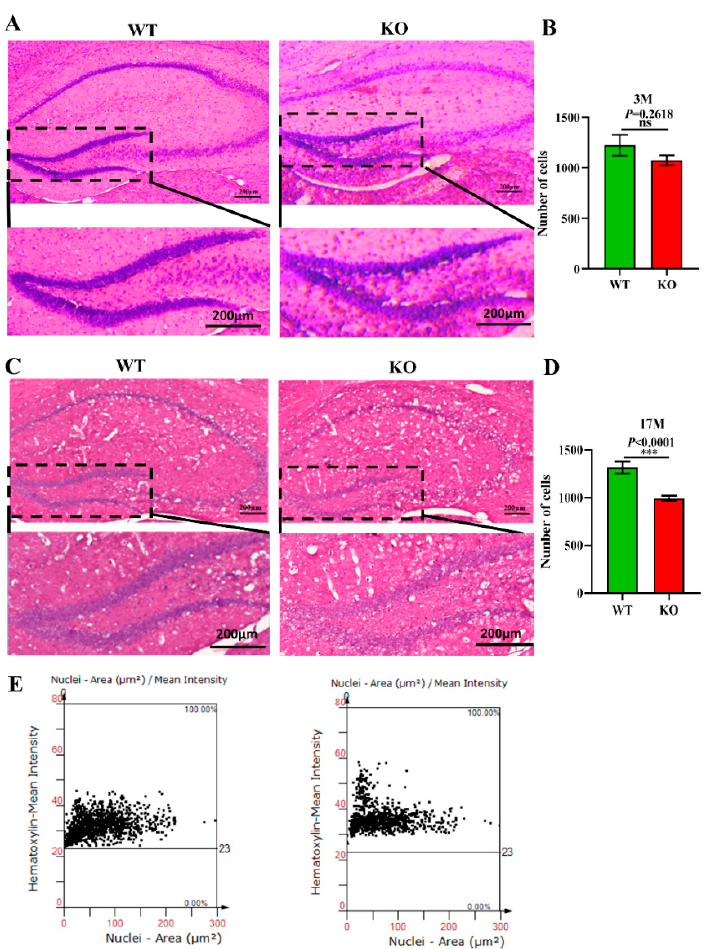
Figure 4. Atp11b deletion reduces the number of cells in the hippocampal DG region. ( A ) H&E staining of the hippocampus from 3-month-old WT and KO mice. ( B ) The number of cells in the DG region of 3-month-old mice. For each group of mice, n = 3. ( C ) H&E staining of the hippocampus in 17-month-old WT and KO mice. ( E ) The number of cells in the DG region of 17-month-old mice. ( D ) Scatter plot of the number of cells in the hippocampal DG region of 17-month-old mice. For each group of mice, n = 4; scale bars: 200 µ m. Data are expressed as the mean ± SEM. Student’s t -test, *** p < 0.0001.